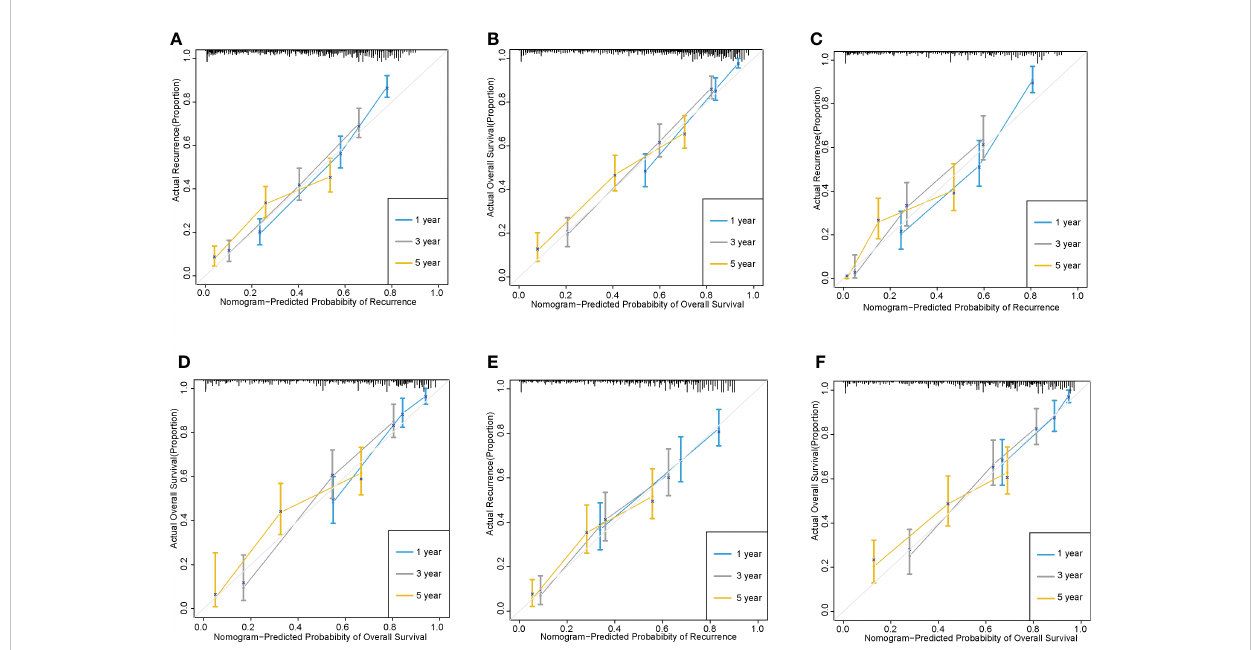
FIGURE 3 The calibration curves of recurrence and OS based on nomogram prediction and actual observation. 1-, 3- and 5-year recurrence and overall survival in the training cohorts (A, B) ; 1-, 3- and 5-year recurrence and overall survival in the internal validation cohorts (C, D) ;1-, 3- and 5-year recurrence and overall survival in the external validation cohorts (E, F) .